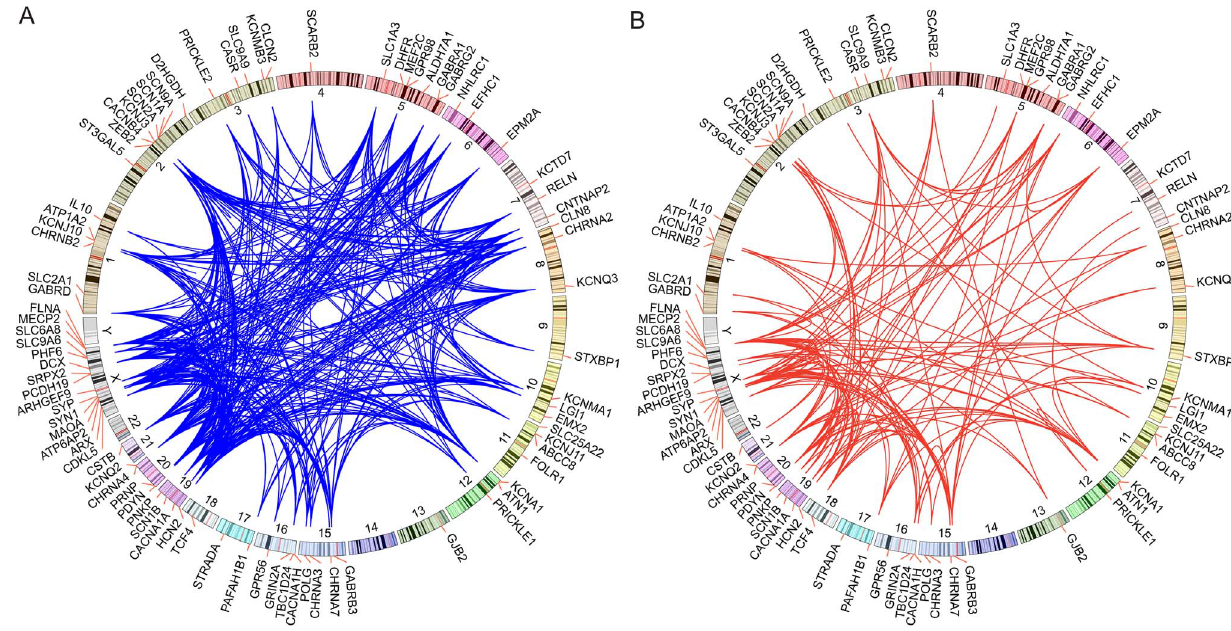
Figure 1. Network analysis of genes associated with epilepsy. Circos plots are drawn with the positions of a set of 83 training genes indicated along the circumference of the circles. A. Blue edges are drawn between genes if a given pair of genes shares an annotation to the same rare MGI knockout mouse phenotype mapped to the human orthologue. Rare annotations are defined as being annotated to 200 or fewer genes. B. Red edges are drawn between pairs of genes if their respective protein products physically interact or interact though exactly one intermediate interactor.